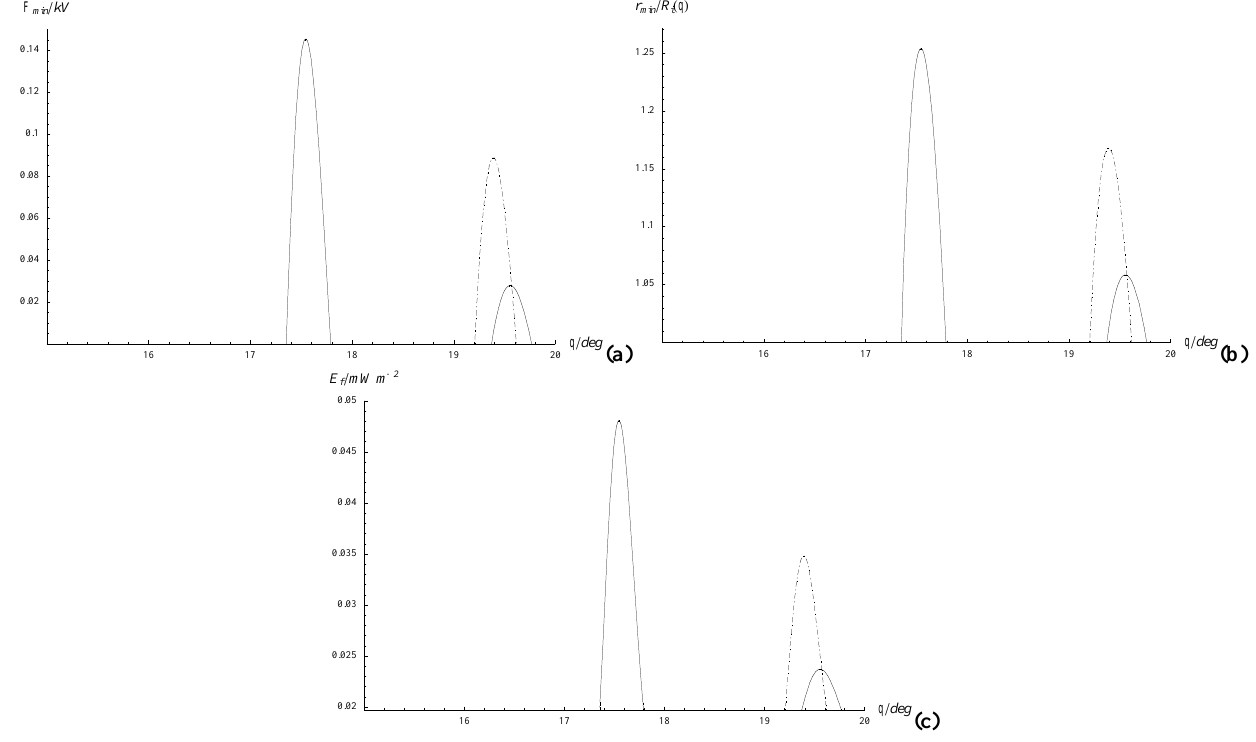
Fig. 7. Plots showing auroral electron acceleration parameters on an expanded co-latitude scale for the Voyager-1 angular velocity model = 1mho, for the Northern Hemisphere (solid lines) and Southern Hemisphere (dot-dashed lines). (including small-scale features) and 6 ∗ P These have been derived using Eqs. (20)–(24), with N = 0 . 2cm − 3 and W th = 150eV. (a) Shows the minimum accelerating voltage obtained from Eq. (22). The two peaks in the Northern Hemisphere at ∼ 17.6 ◦ and ∼ 19.6 ◦ correspond to the ‘Rhea’- and ‘Dione’-related angular velocity features, respectively. The single peak in the Southern Hemisphere at ∼ 19.4 ◦ corresponds to the ‘Rhea’ feature. The ‘Dione’ feature does not have sufficient current density to require field-aligned acceleration in the Southern Hemisphere. (b) Shows the minimum radial distance of the top of the acceleration region in planetary radii, obtained from Eq. (23). (c) Shows the energy flux of the precipitating auroral electrons, obtained from Eq. (24). The energy flux scale starts at the estimated level of the unaccelerated background precipitation from the magnetosphere, i.e. at ∼ 0.02mWm − 2 . The associated UV auroral emission can be estimated in kR by multiplying the precipitated energy flux by a factor of ∼